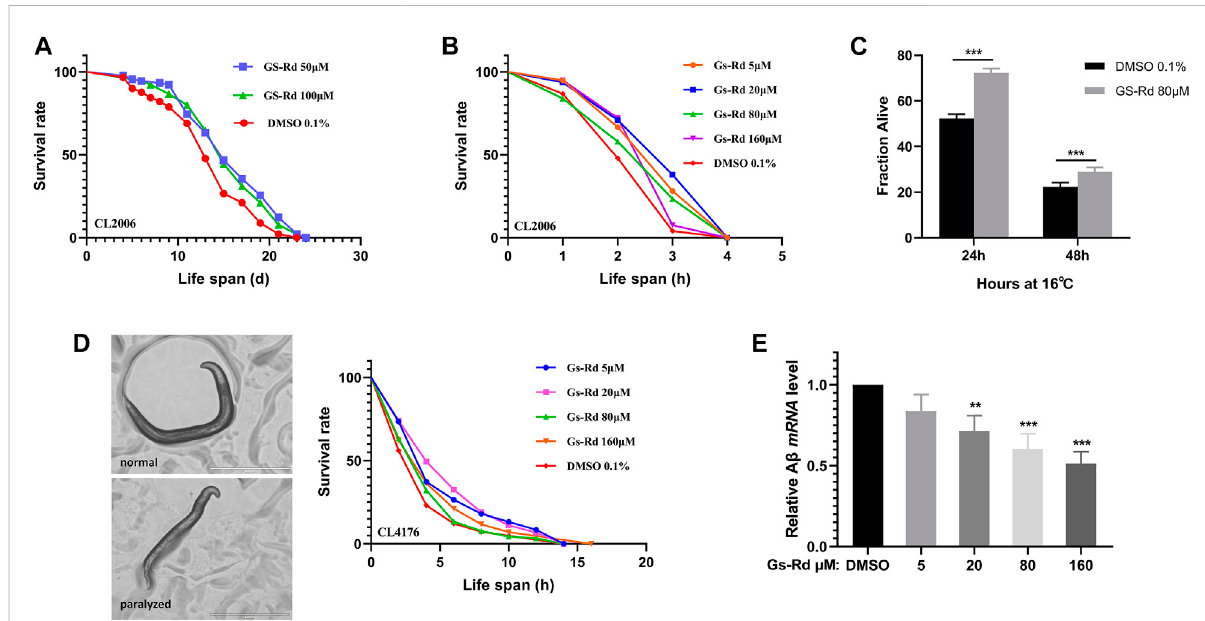
FIGURE 6 Effects of GS-Rd on the lifespan and heat tolerance of CL 2006. (A) Lifespan of GS-Rd treated or no treat CL2006 worms. (B) Survival rate of CL2006 worms in heat resistance experiments. Heat resistance experiments were carried out at 35 ° C and calculated by 1 h. (C) Survival rate of CL2006wormsinheatresistancerecoveryexperiment.Theexperimentswerecarriedoutat35 ° Cfor7h,thentransferredto16 ° Candthenumberof deadwormswasmeasuredafter24and48 h. (D) MicroscopeimagesshowCL4176wormswereparalyzedinlarvalstatus. (E) TheA β mRNAlevel was measured by RT-qPCR. Error bars indicate SE. *p < 0.05, ***p <